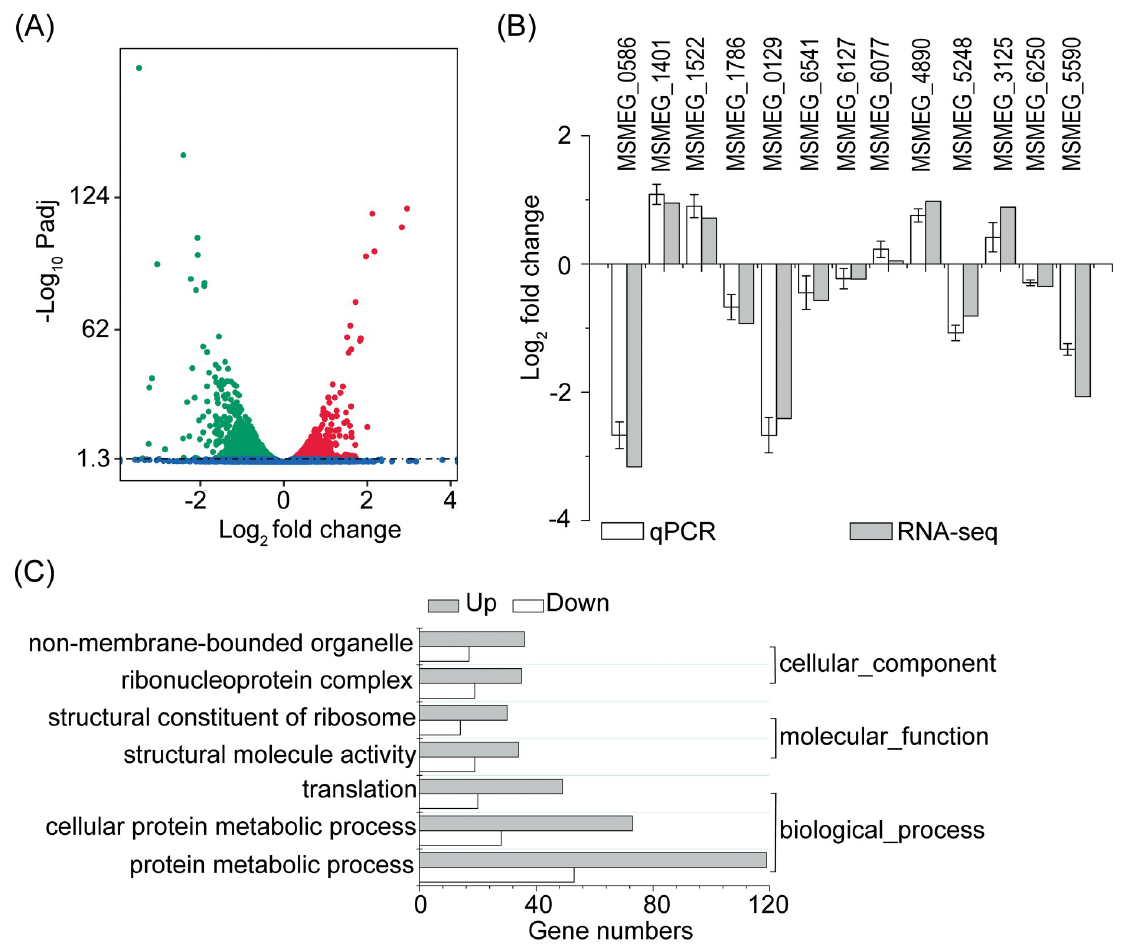
Fig 2. Differentially expressed genes in the M0129C_T0 versus M0129C_T20 comparison. (A) Volcano plot showing differentially expressed genes. Green, down-regulated genes. Red, up-regulated genes. Blue, genes not differentially expressed. Padj, adjusted p-value. (B) qPCR analyses of 13 randomly selected DEGs. (C) Significantly enriched gene ontology (GO) terms (adjusted p-value < 0.05).